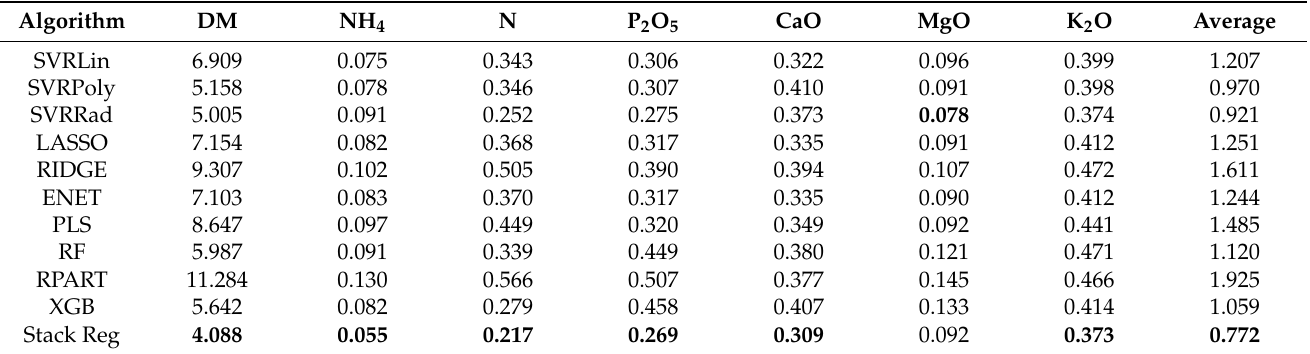
Table 6. Comparison of the root mean square error of prediction ( RMSEP ) (% wet weight) among the seven chemical components: dry matter (DM), total ammonium nitrogen (NH 4 ), total nitrogen (N), P 2 O 5 , CaO, MgO, and K 2 O of the fresh homogenized samples using various machine learning techniques (SVRLin = support vector regression with linear kernel; SVRPoly = support vector regres- sion with polynomial kernel; SVRRad = support vector regression with radial kernel; LASSO = least absolute shrinkage and selection operator; RIDGE = ridge regression; ENET = elastic net regression; PLS = partial least squares; RF = random forests; RPART = recursive partitioning and regression trees; XGB = boosted trees). Best results are indicated in bold.